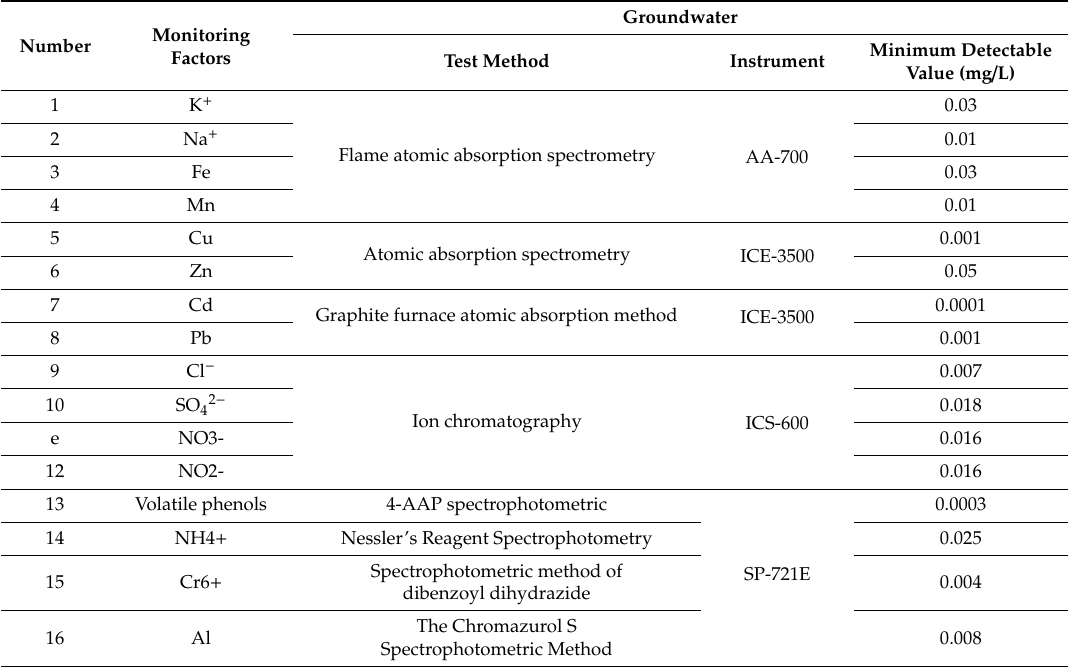
Table 2. Analytical methods and minimum detection